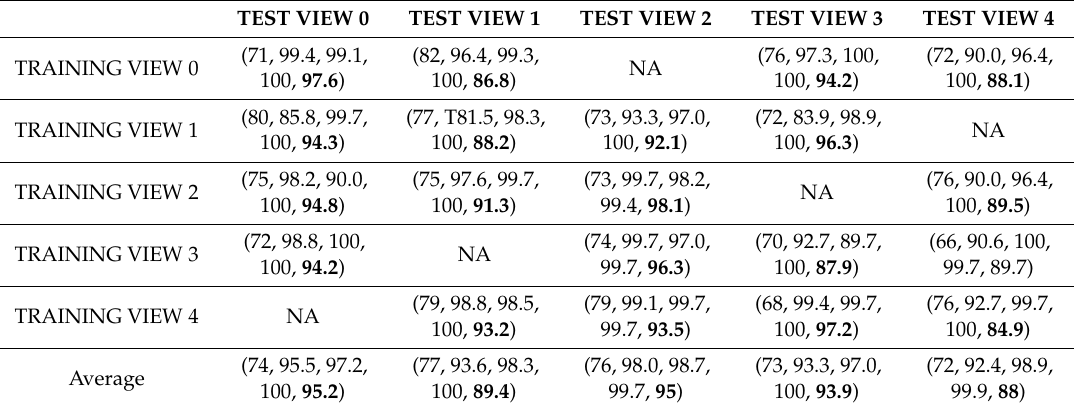
Table 2. One-to-one cross-view recognition outcome for different controlled methods on the IXMAS dataset. The values enclosed in brackets are the recognition accuracies for [8,29,41,42] and our supervised method (with and without the p